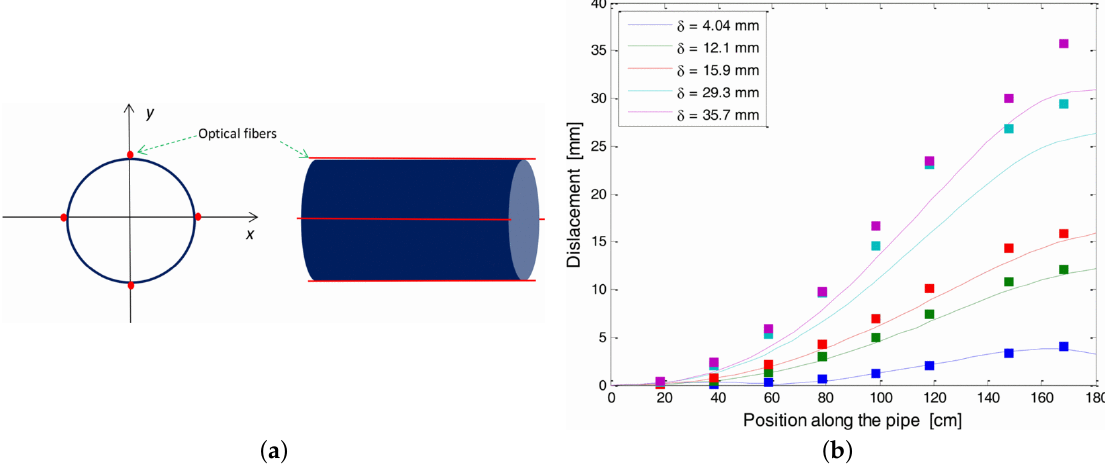
Figure 19. ( a ) Optical fibre inclinometer based on a BOTDA scheme; ( b ) Displacement curves measured by the optical fibre inclinometer (solid lines) vs. dial gauges (squares). Reproduced with permission from